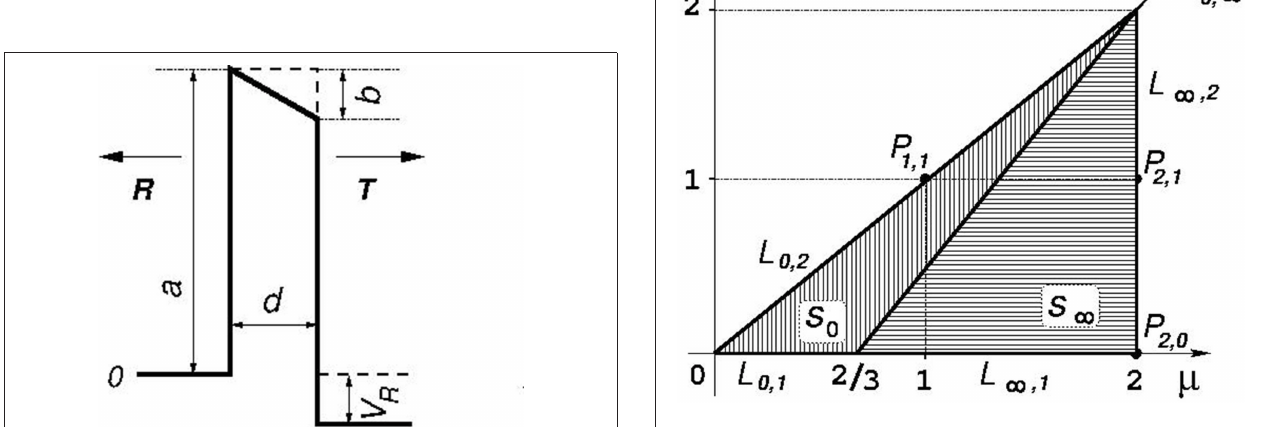
FIGURE 1 | Schematics of one-layer potential (63) tilted by difference V 1 (solid line) with notations given in (65) at ε line represents potential with b